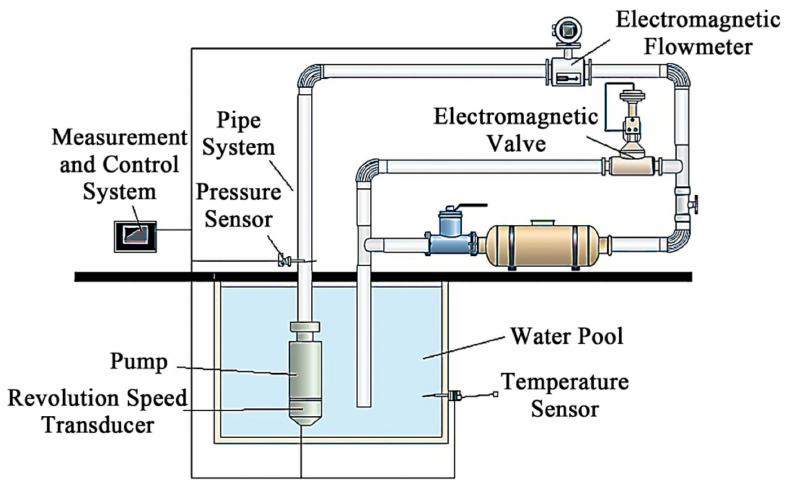
Figure 4. Layout of the clear water experimental system.